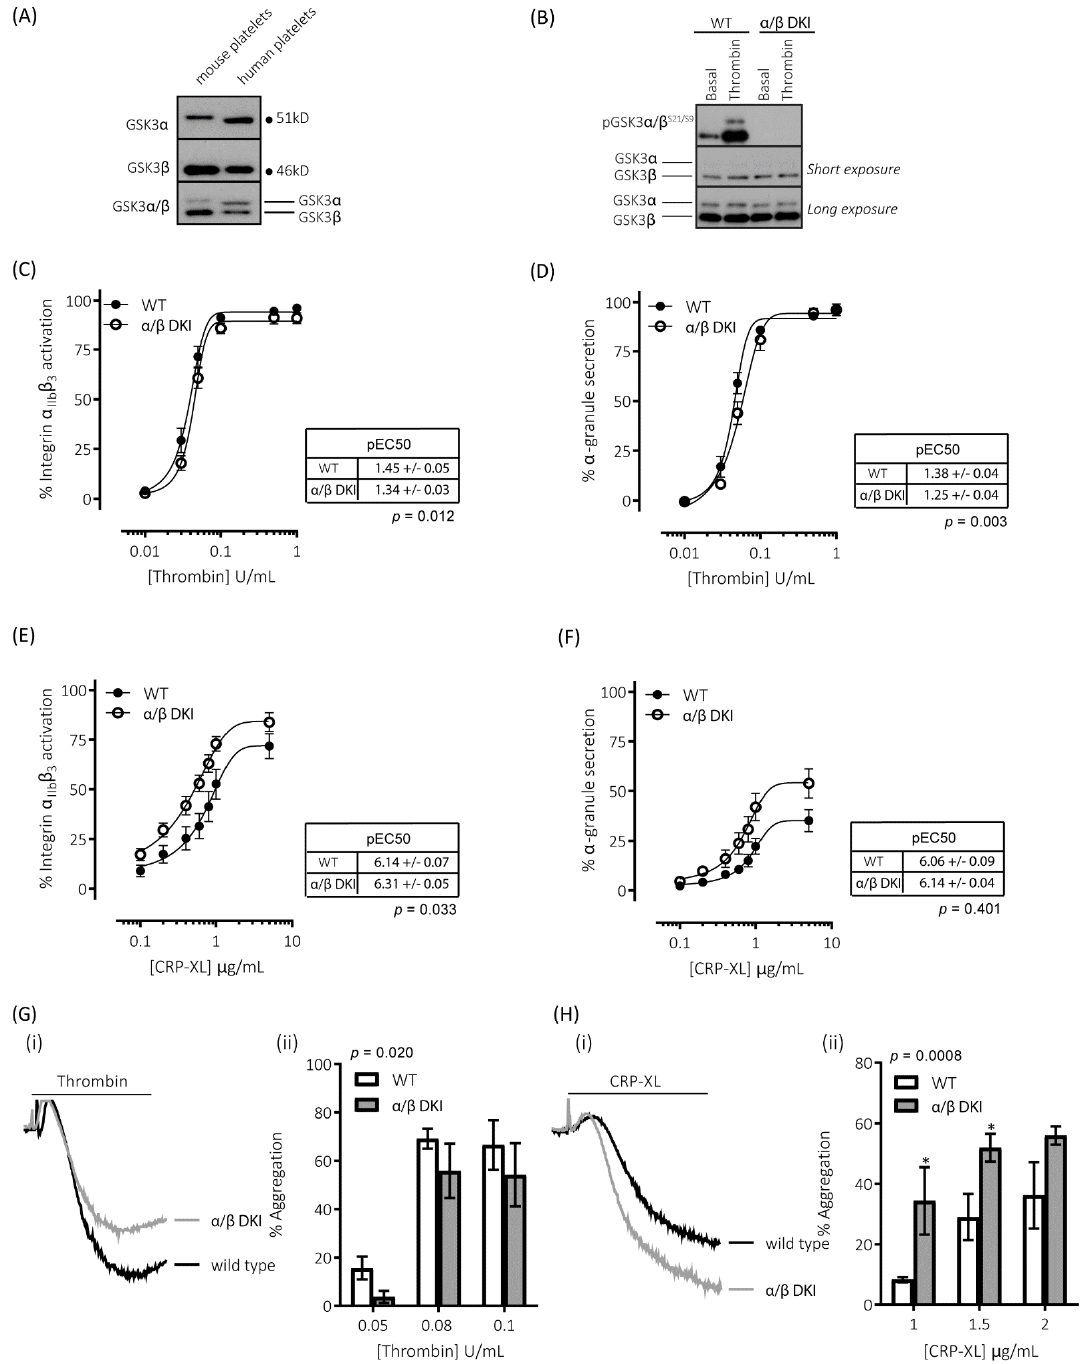
Figure 1. Platelets expressing phosphorylation-resistant GSK3 have differentially altered responses to thrombin and CRP-XL : ( A ) Immunoblotting of human and mouse platelet lysates demonstrating the expression of both paralogs of GSK3. GSK3 α was observed to run at ~51kD and GSK3 β at ~46kD. ( B ) Platelets from mice expressing phosphorylation- resistant GSK3 ( α / β DKI) were found to express both GSK3 α and GSK3 β at levels equivalent to platelets from wild-type